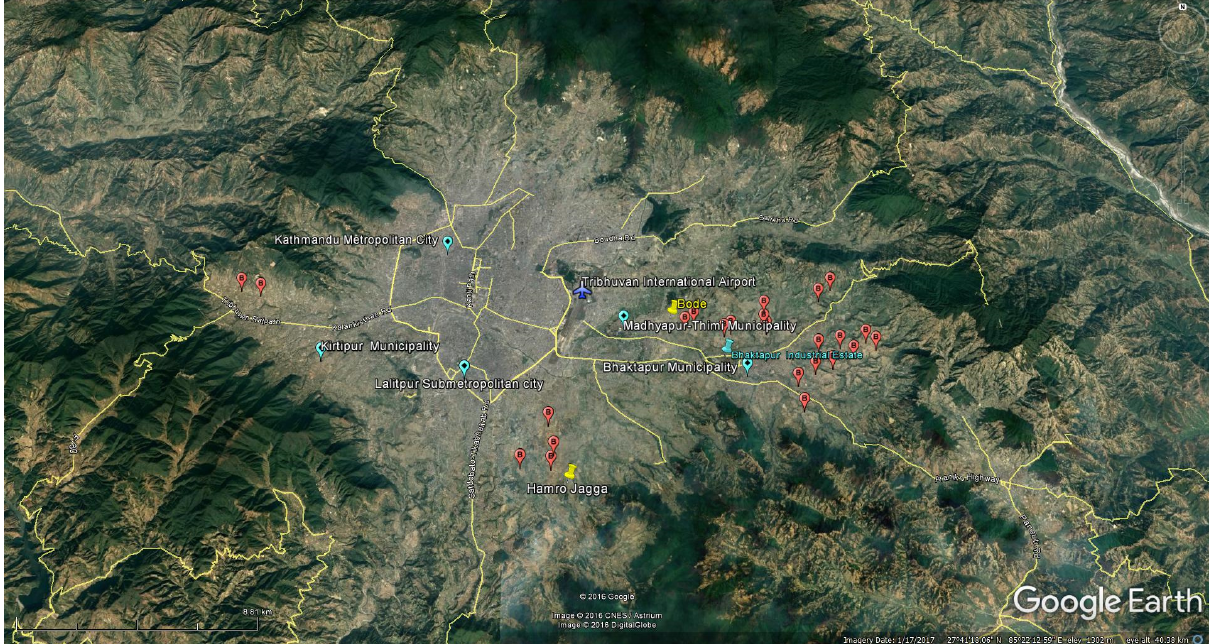
Figure 1. Location of the measurement site Bode and the five major cities in Kathmandu Valley: Kathmandu, Lalitpur, Bhaktapur, Kirtipur and Madhyapur-Thimi. The major roads are highlighted, clusters of brick kilns are marked (B). Google Earth, 2016; ©2016 Google, image© 2016 CNES/Astrium, image© 2016